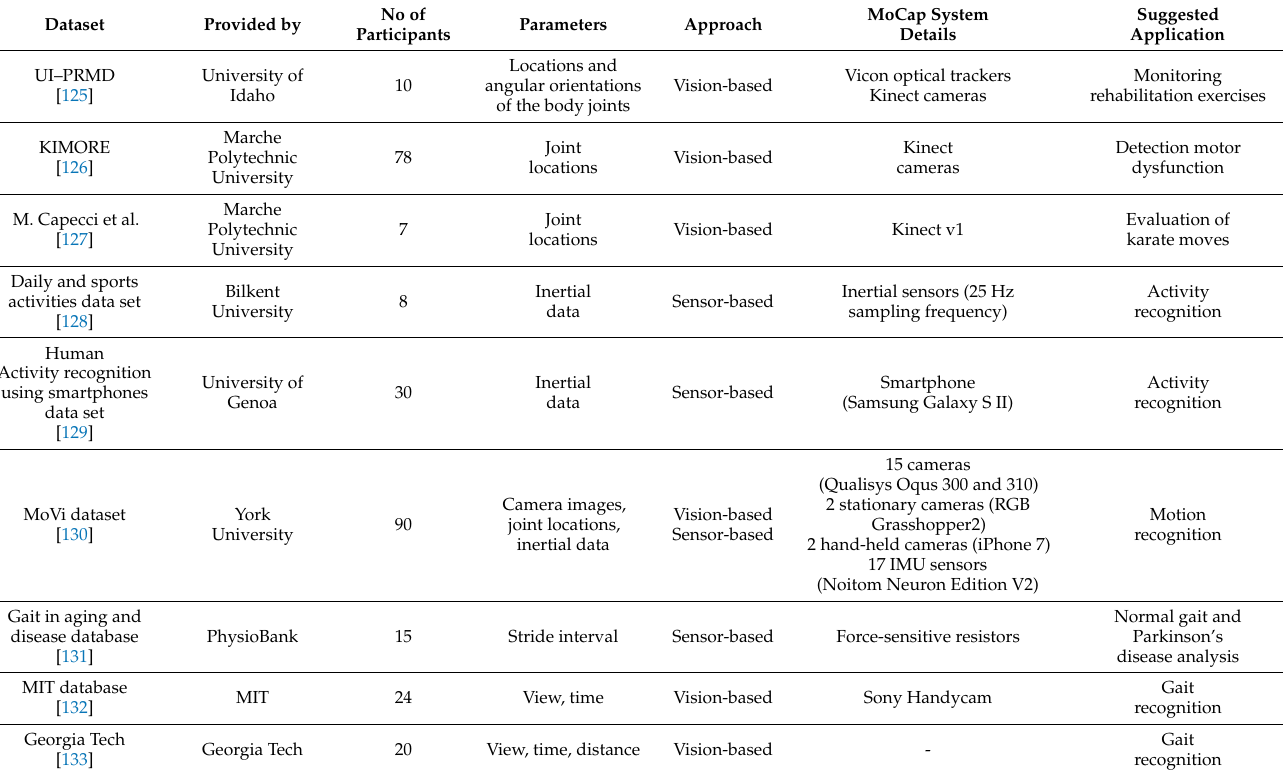
Table 6. Table summarizing the datasets previously discussed, classified according to the number of participants, the acquisition system, the detected parameters, and the suggested